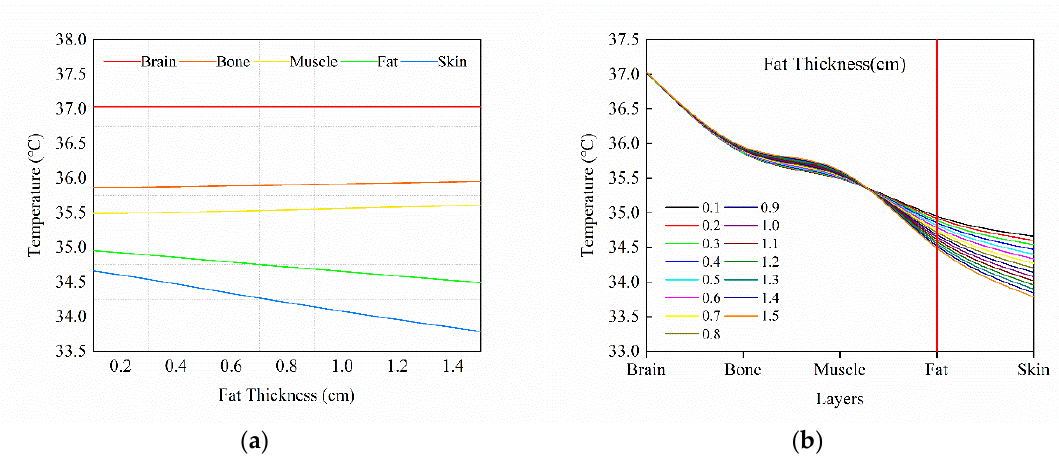
Figure 8. ( a ) Temperature variation by fat thickness step change; ( b ) Tissues temperature distribution under different fat thickness.